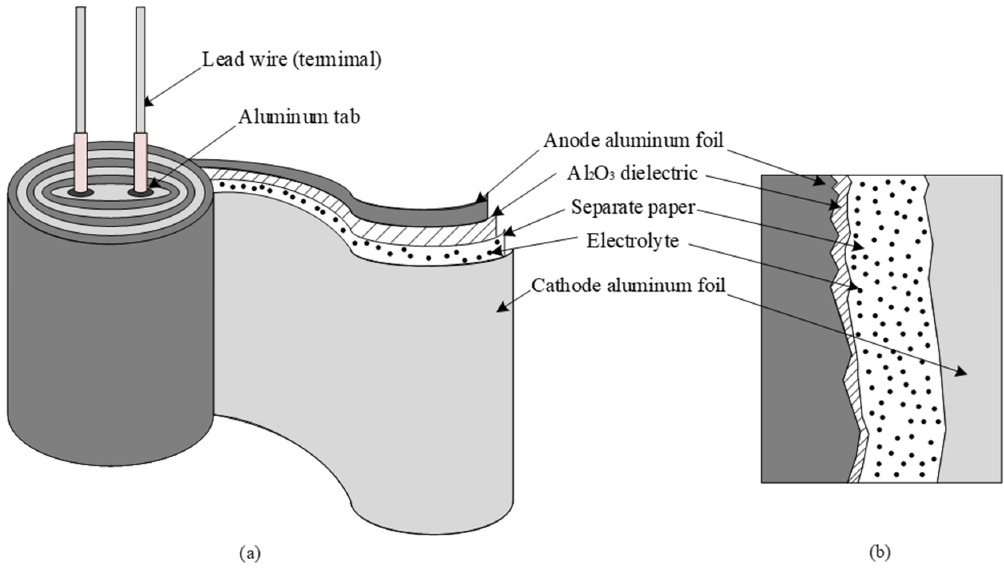
Figure 1. Constructions of an aluminum electrolytic capacitor (Al-Cap): ( a ) cylinder construction; ( b ) cross section of cylinder.